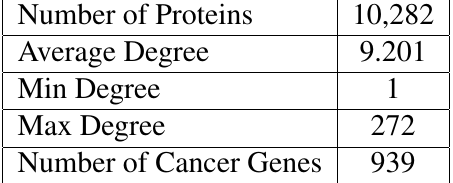
Table 2: Statistical information of union of three human PPI datasets: HPRD [29], BIOGRID [30] and Radivojac et al.